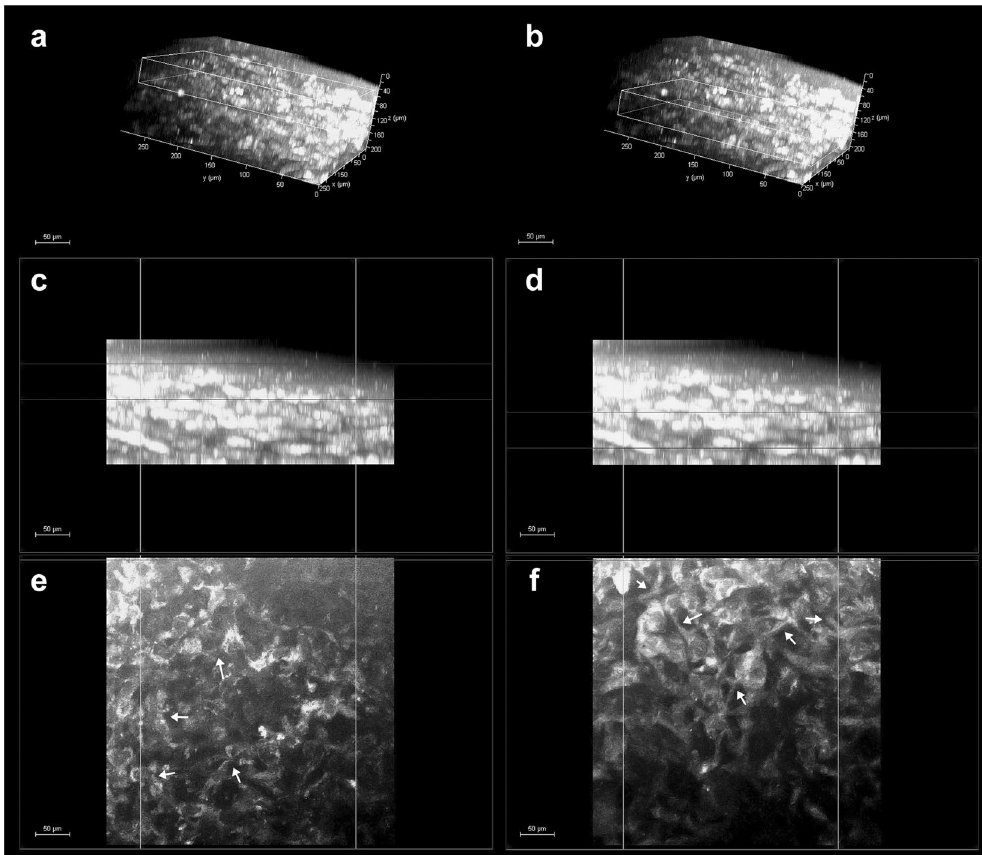
Figure 3. Corneal stroma keratocytes in the hemicornea . ( a and b ) 3D reconstruction of the hemicornea (TPEF signal) showing the stromal keratocytes at different depths (scale bar 50 µ m). The white box in panel A encloses the anterior stroma ranging between 40 and 90 µ m depth ( c and e ); the white box in panel b encloses the stroma ranging between 120 and 170 µ m depth ( d and f ). The panels c, d and e, f show the cross-section and en face images of the hemicornea stroma respectively. The stromal keratocytes show a dendritic-like morphology with processes connecting the cells to each other forming cellular networks (syncytium;